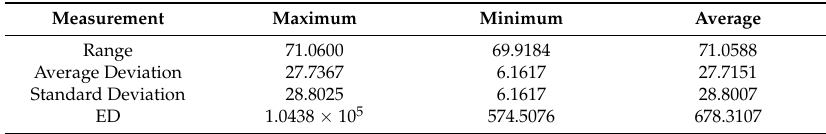
Table 3. The comparison results for several dispersion